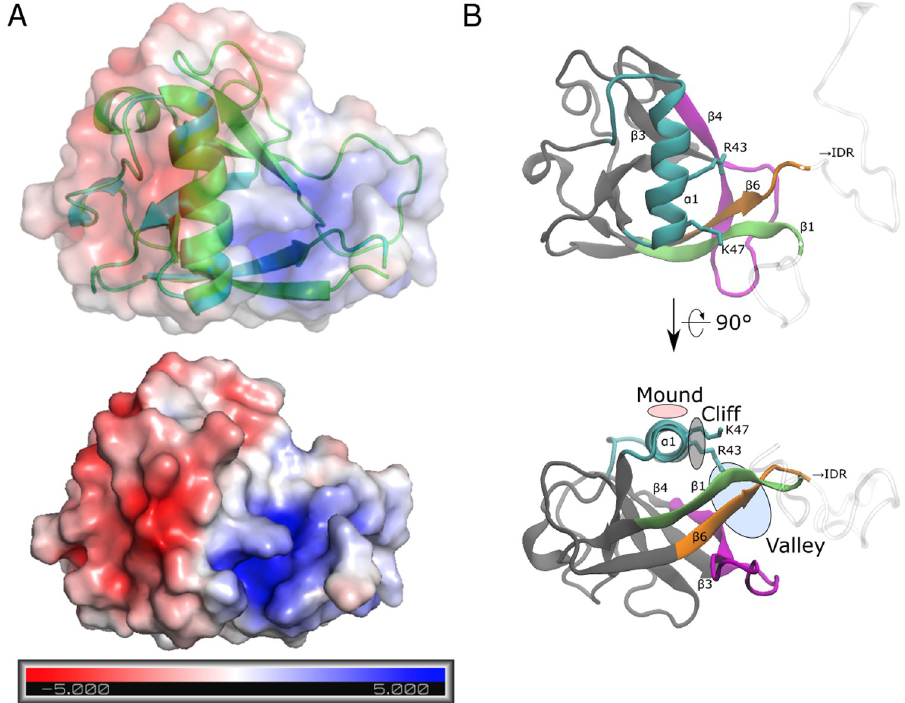
Fig 5. Binding surface of nsp1. (A) Surface electrostatic potential of the nsp1 and (B) annotated surface structure of the nsp1 recognition sites for SL1. In (A), units are in k the system (= 300 K), and e is the unit charge of a proton. Color coding in (B) corresponds to the region defined in Fig 1D.